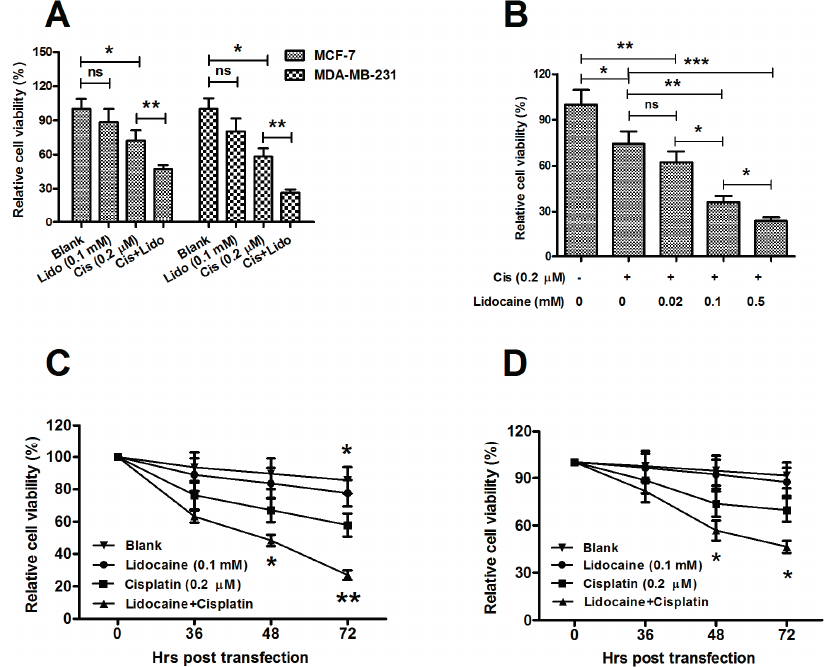
Figure 3. Lidocaine reduces the viability of MCF-7 and MDA-MB-231 cells in the presence of cisplatin. ( A ) Relative viability of MCF-7 and MDA-MB-231 cells treated with 0.2 μ M cisplatin or (and) 0.1 mM lidocaine for 72 h; ( B ) Influence of 0.02, 0.1 or 0.5 mM lidocaine on the viability of 0.2 μ M cisplatin-treated MCF-7 cells for 72 h; Relative viability of MCF-7 ( C ) or MDA-MB-231 ( D ) cells treated with 0.2 μ M cisplatin or (and) 0.1 mM for 36, 48 or 72 h. All results were averaged for triple independent experiments. And each statistical significance was considered when p ˂ 0.05 or less. * p ˂ 0.05, ** p ˂ 0.01, or *** p ˂ 0.001, ns: no